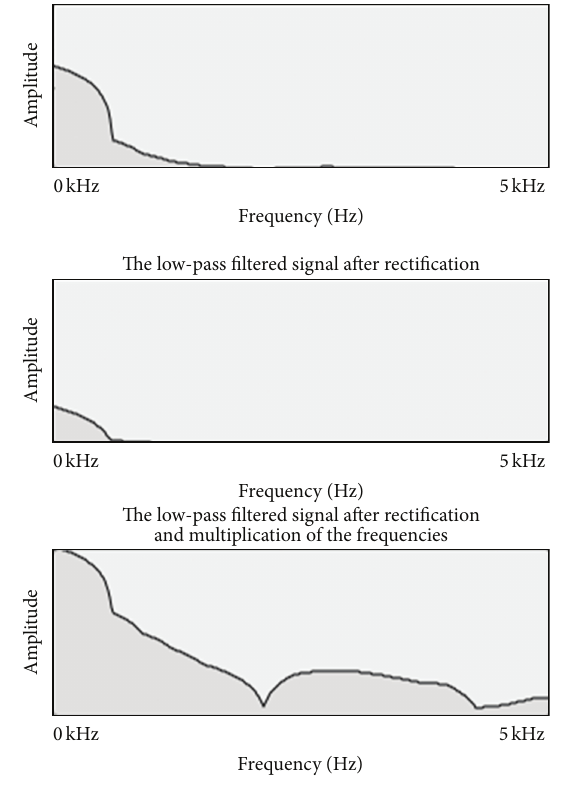
Figure 9: Illustration of the process of the rectification and multi- plication of the low-pass filtered noise controlling the amplitude of the band-pass filtered noise for generating the natural random-noise bursts.